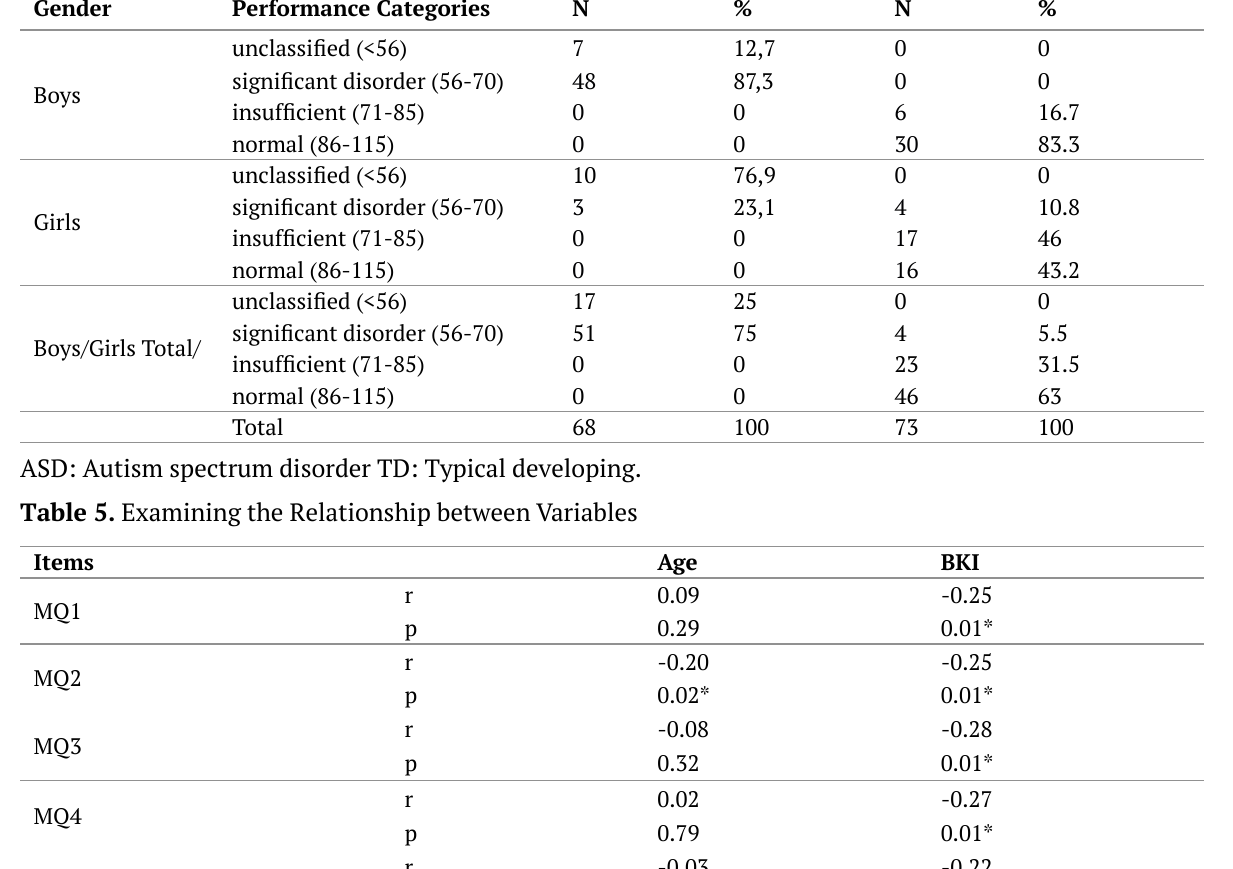
Table 4. .The results of a comparison of performance classification values by group and gender. ASD Group TG Group